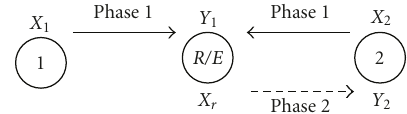
Figure 1: Two-hop communication using an untrusted